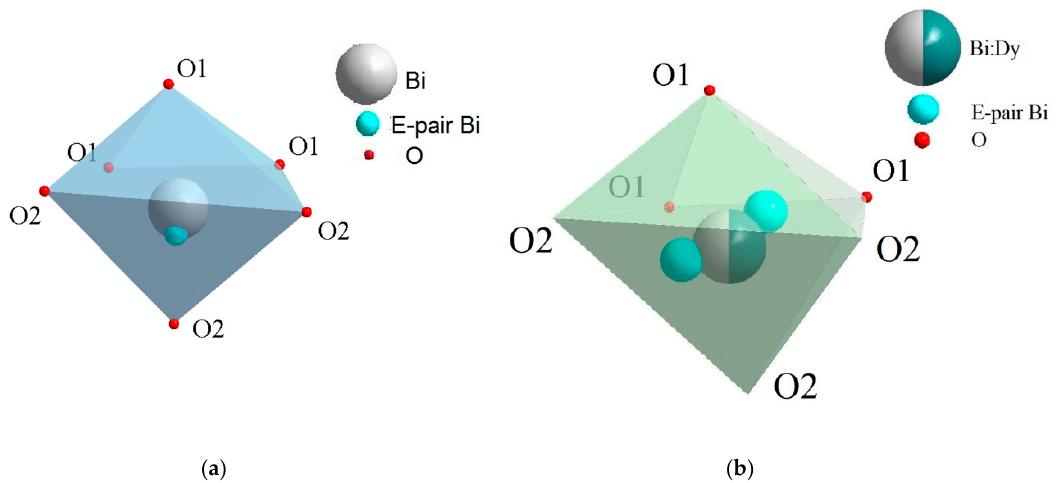
Figure 6. Coordination polyhedra in the ( a ) Bi 24 M 2 O 40 and ( b ) Bi 4 Ge 3 O 12 structures.